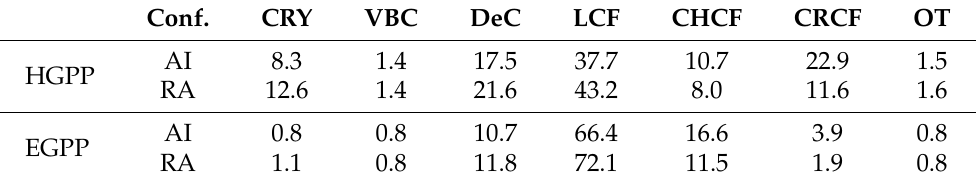
Table 8. Comparison of the number of fps decoded by different VVC implementations. Reference